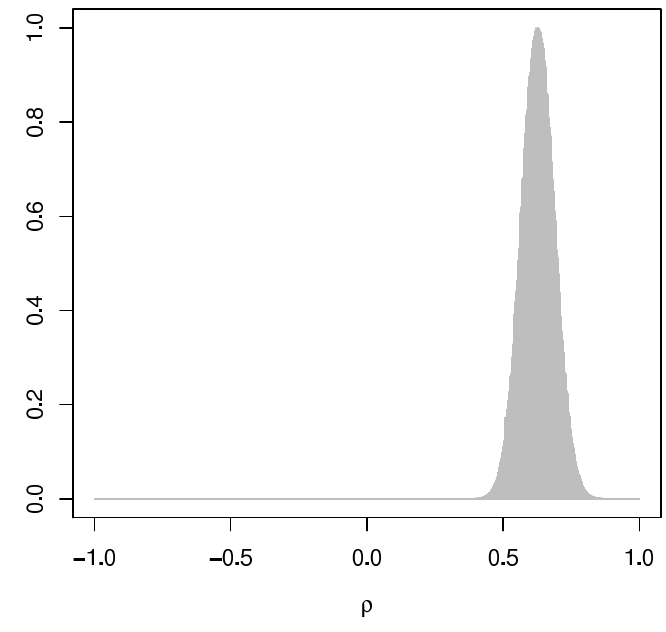
Figure 6 { Approximation of the posterior distribution of the Spearman’s ρ for the log- returns of the investments of two Italian institutes based on 10 , 000